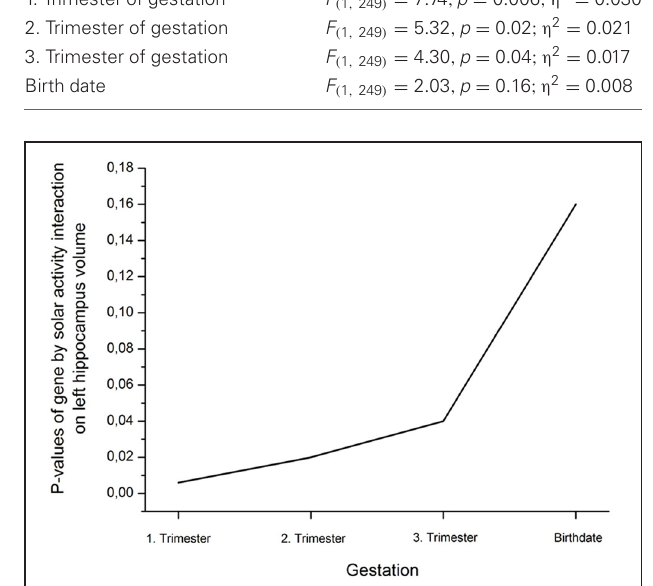
FIGURE 2 | Decline (rise of p -values; η 2 are presented in Table 2) of the interaction effect gene by solar activity from the first trimester to birth on left hippocampus